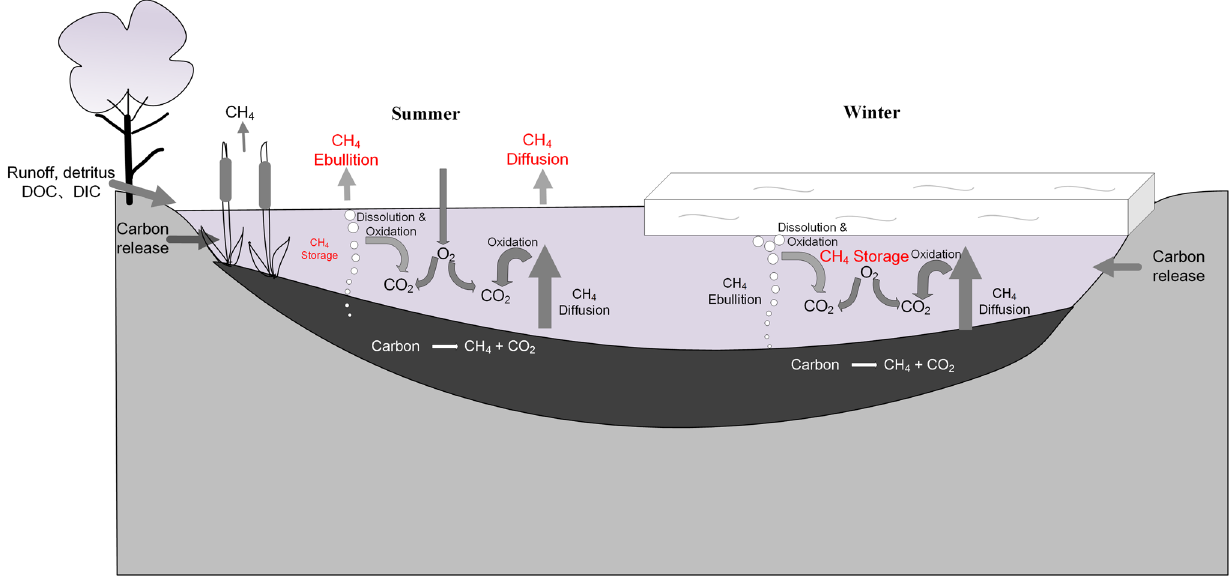
Fig. 2 Methane dynamics in northern seasonally ice-covered lakes during the summer and